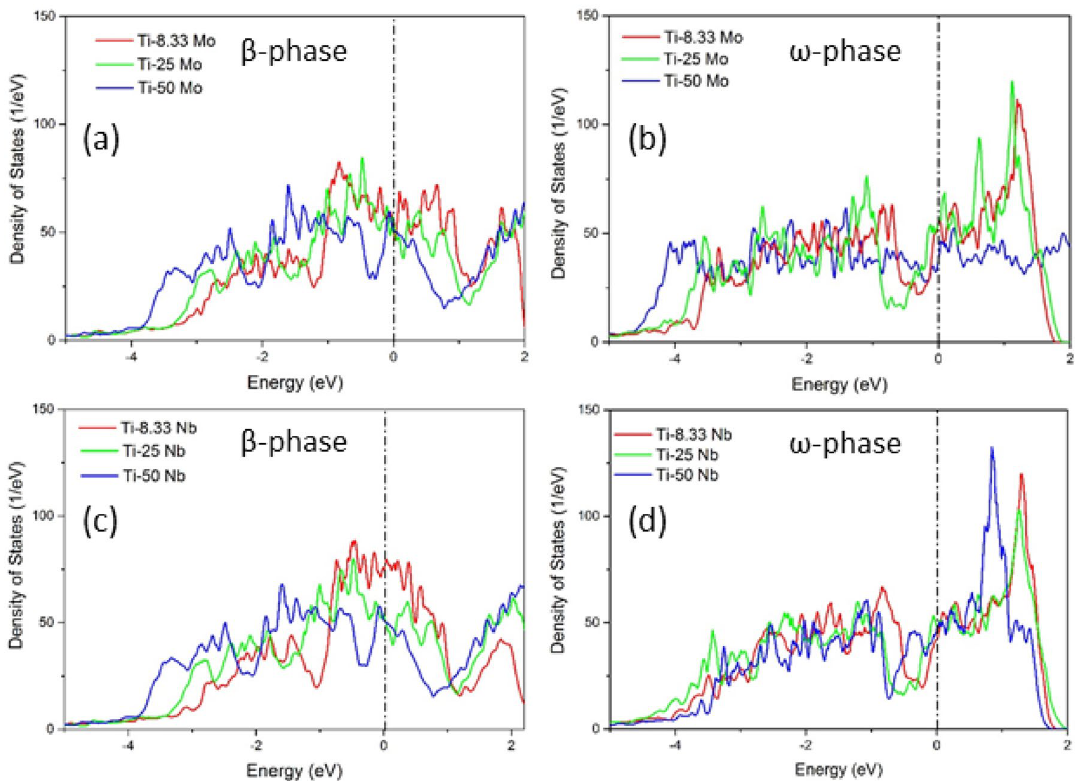
Figure 9. The calculated total density of states (DOS) in Ti-Mo and Ti-Nb binary alloys. ( a , b ) are respectively DOS of β and ω-phases in Ti-Mo. ( c , d ) are respectively DOS of β and ω-phase in